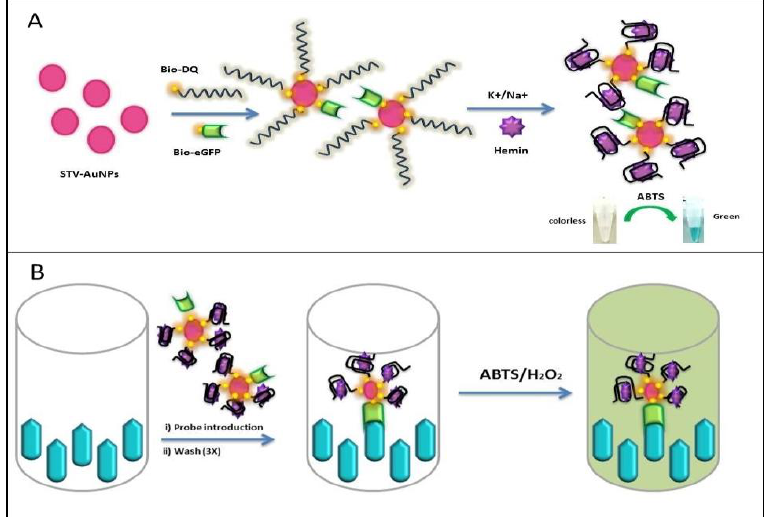
Figure 1. Schematic diagram of STV-AuNPs and Ag-Ab/DNAzyme conjugation as probe ( A ) for immunoassay system ( B